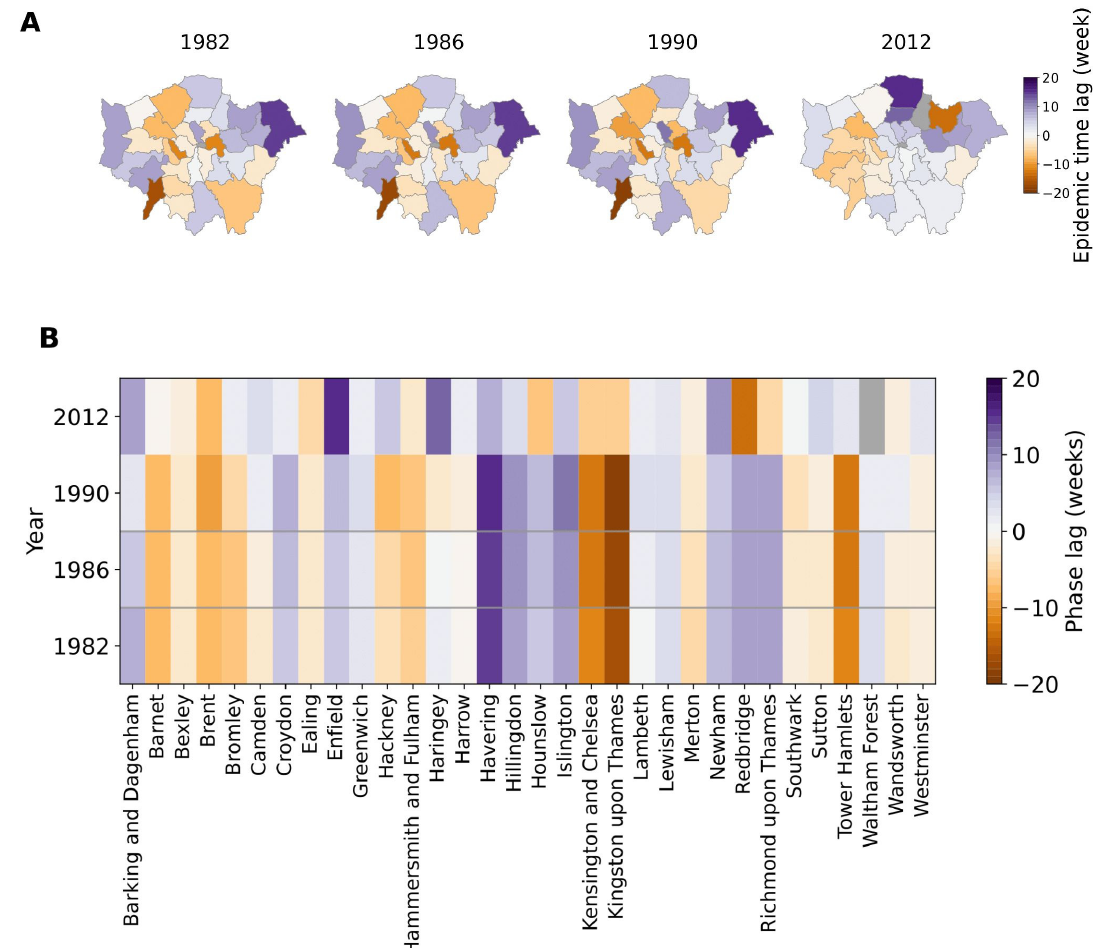
Fig 4. Pertussis epidemic phase lag among London boroughs in 1982, 1986, 1990 and 2012. Leading and lagging boroughs are shown in purple and orange respectively (A) Mapping of the phase lags at four different time snapshots. Map base layers are obtained from London Datastore (https://data.london.gov.uk/dataset/statistical-gis-boundary-files-london) and are available from https://data.london. gov.uk/download/statistical-gis-boundary-files-london/9ba8c833-6370-4b11-abdc-314aa020d5e0/statistical-gis-boundaries-london.zip (The digital boundary file contains Office for National statistics data Crown copyright and database (2012) and contains Ordnance Survey data Crown copyright and database (2012)). (B) Phase lag across time, depicting a consistent spatial organization among the boroughs at the first three